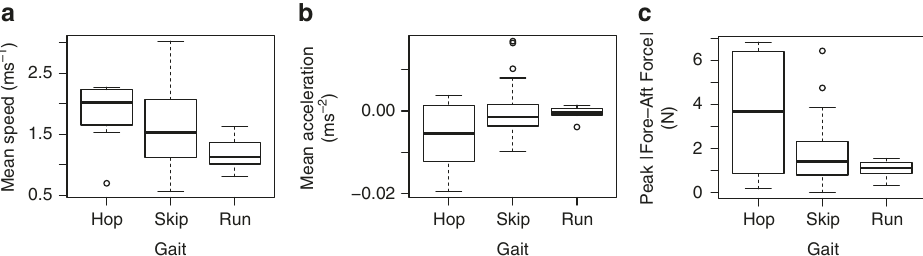
Fig. 1 Jerboa gaits are not associated with the distinct speed ranges expected for cursorial locomotion. Boxplots showing a mean speed (magnitude of total x - and z -direction velocity), b mean acceleration (derivative of speed in a ), and c the peak absolute value of fore-aft force recorded by the force platform over n = 80 trials. Mean speed is not as strong a predictor of gait ( F 2,77 = 2.82, P = 0.07, one-way ANOVA) in J. jaculus as mean acceleration ( F 2,77 = 3.99, P = 0.02, one-way ANOVA). The boxes span the interquartile range, the bold line represents the median, the whiskers extend to 1.5 times the interquartile range, and the open circles show outlier values outside of the whiskers